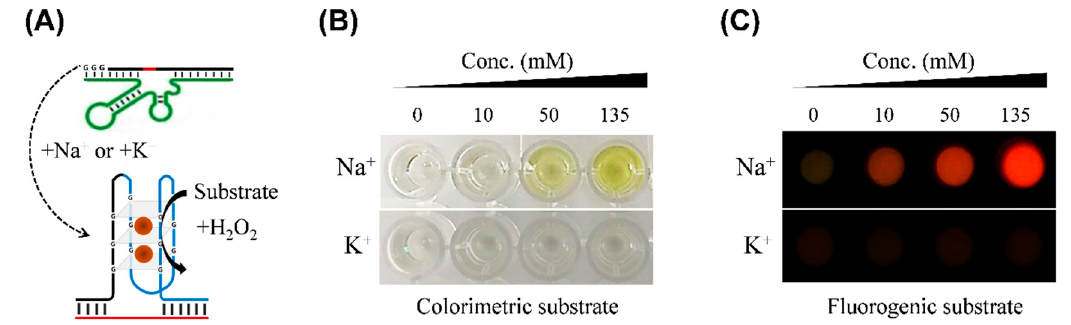
Figure 3. Na + -specific reaction of sequential DNAzymes with different detection mode: ( A ) schematic of DNAzyme reactions, ( B ) colorimetric analysis and ( C ) fluorescent analysis. Each signal by Na + or K + ions was compared as a function of concentration (0, 10, 50, and 135 mM).